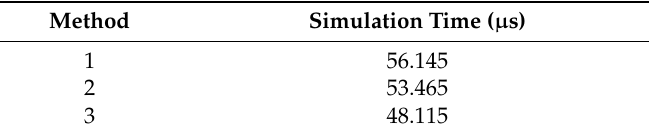
Table 3. Comparison of simulation time for three methods.